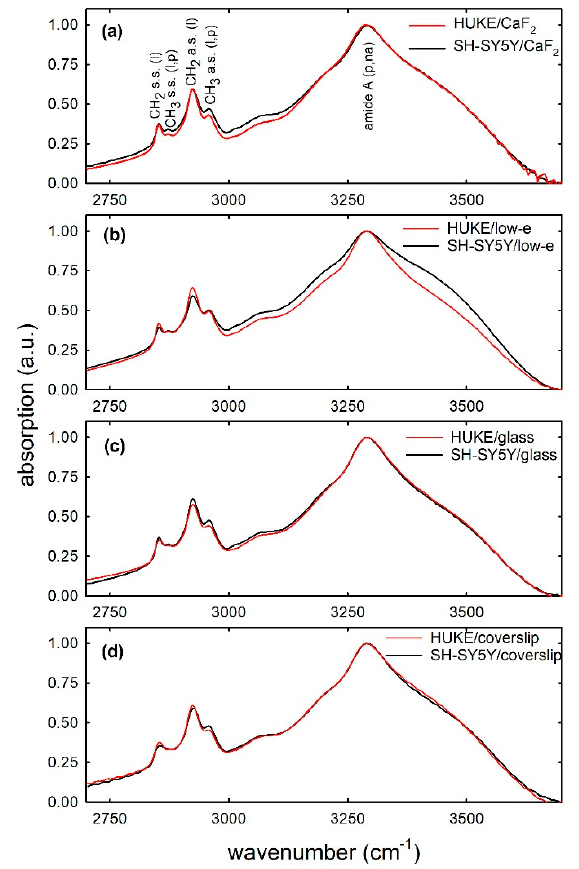
Figure 1. Average normalized FTIR spectra of Human Keratinocyte (HUKE) (red lines) and SH-SY5Y (black lines) cells grown on CaF 2 ( a ), low-emissivity (low-e) ( b ), glass ( c ), and coverslip ( d ) substrates.